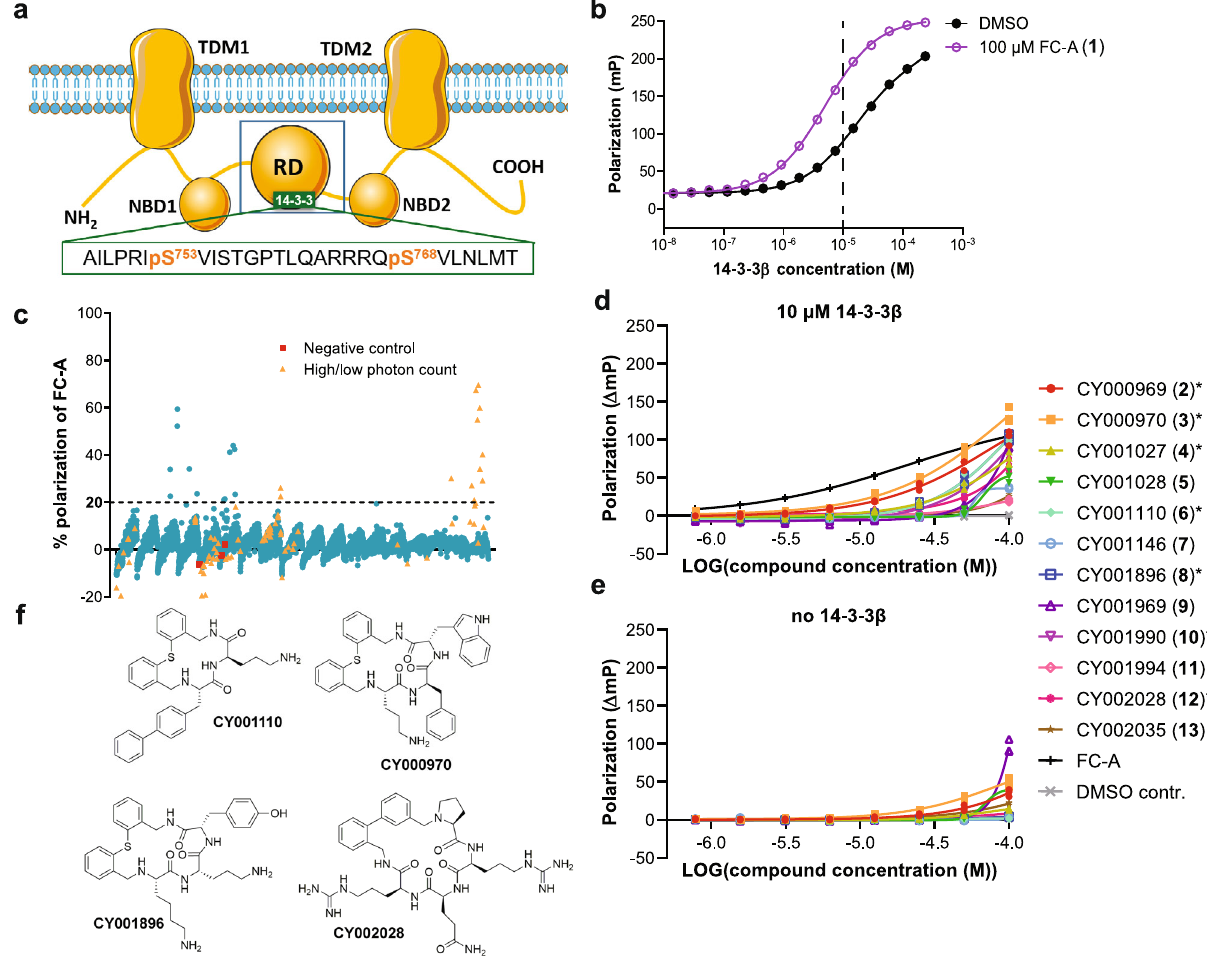
Fig. 1 Screening for stabilizers of the 14-3-3 β /CFTRpS753pS768 complex. a Topology model of CFTR showing the two transmembrane domains (TDM), the nucleotide binding domains (NBD), and the regulatory domain (RD). The 14-3-3 binding motif encompassing the phosphorylation sites pS753 and pS768 (CFTRpS753pS768) was used in this study and is shown as peptide sequence. This sequence — CFTRpS753pS768 — was used in this study as a synthetic peptide. b Fluorescence polarization (FP) assay of fl uorescein isothiocyanate (FITC)-labeled CFTRpS753pS768 peptide (100 nM) with 14-3-3 β , in the absence (black) or presence (purple) of 100 μ M fusicoccin A (FC-A), n = 3 technical replicates. The 14-3-3 β concentration used for the FP screening assay was 10 μ M (dashed line). c HTS FP assay of the Cyclenium library. The samples contain 100 nM of FITC-CFTR_pS753pS768 peptide, 10 μ M 14-3-3 β , and 50 μ M compound. FC-A (100 µ M) was added as a positive control and DMSO as the negative control. Hit compounds are de fi ned as a polarization increase which is higher than 20% of the response of FC-A. Red squares are compounds that appeared positive in the negative control without 14-3-3. Orange triangles gave a suspicious high or low total photon count and need to be treated with care. d The eight-point dose-response FP follow-up assay of the Cyclenium library hit compounds stabilizing the interaction between 14-3-3 (10 μ M) and labeled CFTRpS753pS768 (100 nM) peptide. Background polarization was subtracted from all values, n = 3 technical replicates. Compounds selected for further analysis are indicated with an asterisk. e Polarization in the absence of 14-3-3. Background polarization was subtracted from all values, n = 3 technical replicates. f Representatives from the four chemotypes of active compounds after screening for stabilizers of the 14-3-3 β /CFTRpS753pS768 complex. Source data are provided as a Source Data fi